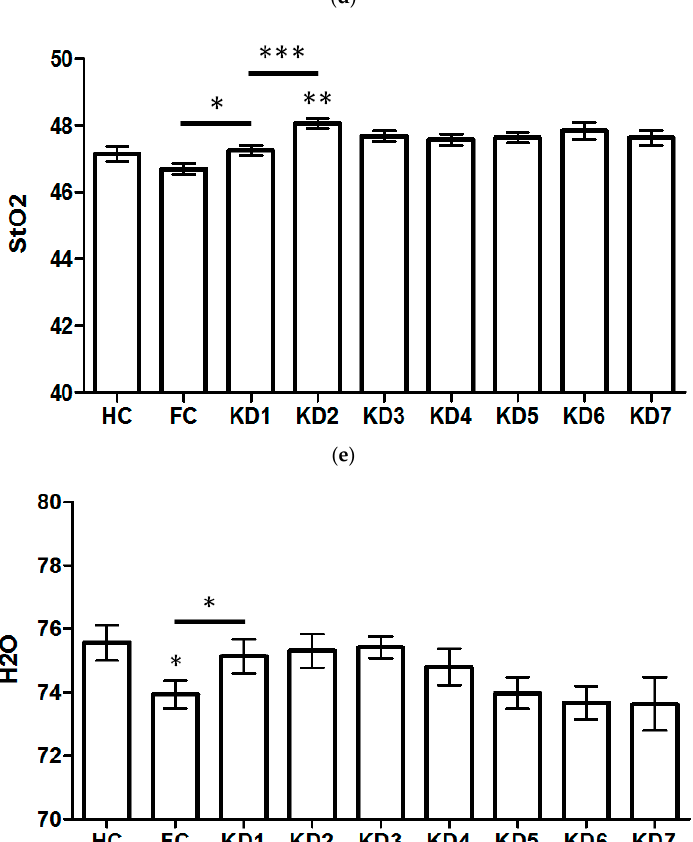
Figure 2. The changes of relative HbO 2 , Hb, HbT, StO 2 , and H 2 O concentrations indifferent disease stages of Kawasaki disease (KD), healthy control (HC), and fever control (FC) are shown in ( a – e ), respectively. The relative HbO 2 of the KD1 group were significantly lower than those of the healthy group. The HbT concentrations of KD1 group were significantly lower than the health group ( p = 0.001) but not the fever control ( p = 0.77). After the acute stage of KD1, both the relative HbO 2 and HbT concentrations gradually increased to similar values as the healthy group. The relative Hb concentration of the KD1 group was significantly lower than that of the healthy group ( p = 0.006) and were still low in KD2 but increased significantly after the KD3 to the KD7 stage. The difference of StO 2 showed significant lower in fever group when compared with the KD1 group and healthy group. The relative H 2 O concentration of the KD1 group was significantly higher than that of fever group ( p = 0.019) but no significant difference with the healthy group. Relative levels of HbO 2 , HbT, and Hb showed significant difference between KD1 and health control while StO 2 and H 2 O showed difference between KD1 and fever control.KD1, within one day before IVIG treatment ; KD2, after IVIG treatment (within three days); KD3, at least 21 days after IVIG; KD4,six months after IVIG; KD5, one year after IVIG; KD6,two years after IVIG; KD7,three years after IVIG; intravenous immunoglobulin (IVIG), * p < 0.05, ** p < 0.01, *** p < 0.001.